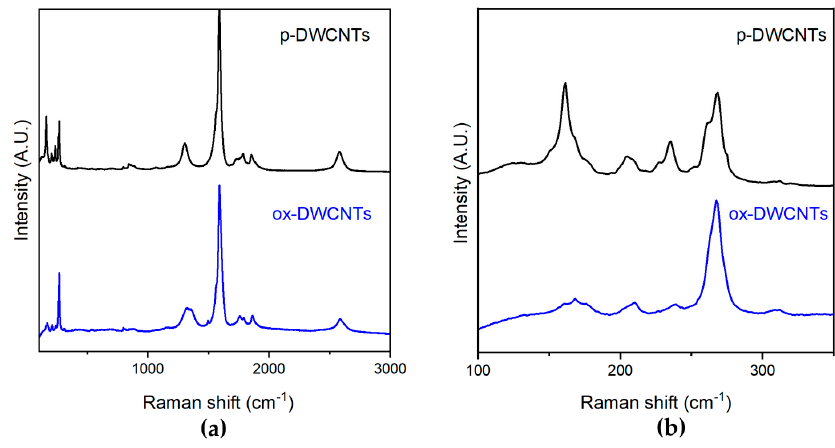
Figure 3. Raman spectra of pristine (p-) and oxidized (ox-) CNTs: ( a ) full-range spectra; ( b ) RBM region to calculate DWCNT diameters (see). Table 1. DWCNTs diameters ( d ) derived from the RBM frequencies ( ω ) [59]. p-DWCNTs